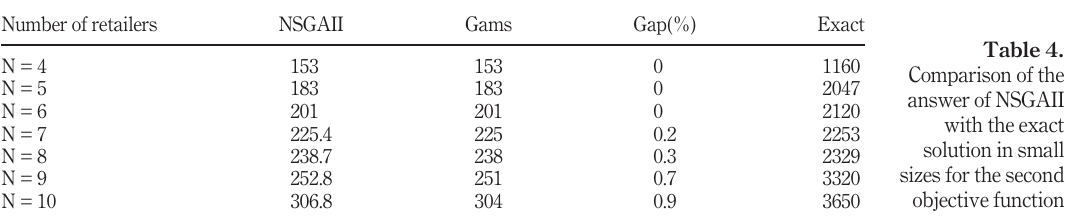
Table 4. Comparison of